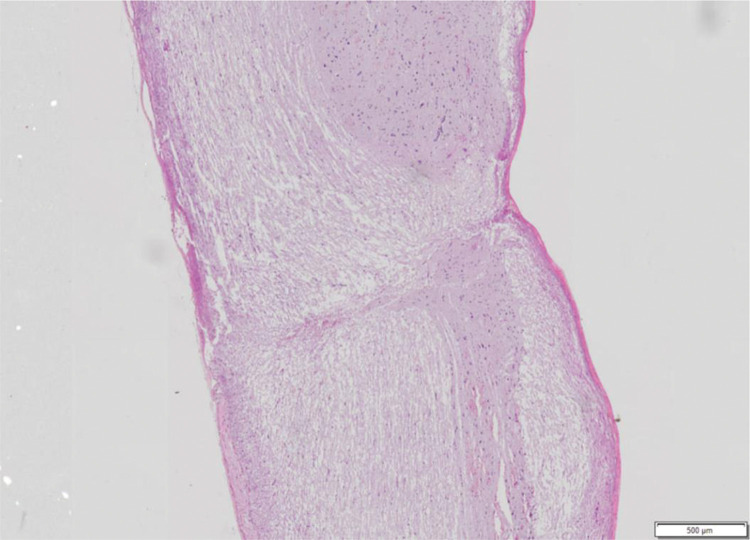
Spinal cord fragment. Sagittal cutting microscopy of spinal cord fragment, animal 7 of group 4. Hematoxylin-eosin staining showing histological features with almost complete interruption of neural bundles, hemorrhage (1+), architectural changes (3+), necrosis (2+) and inflammatory infiltrate (1+). Photo obtained using the Olympus scanner, model VS120, 20x lens.